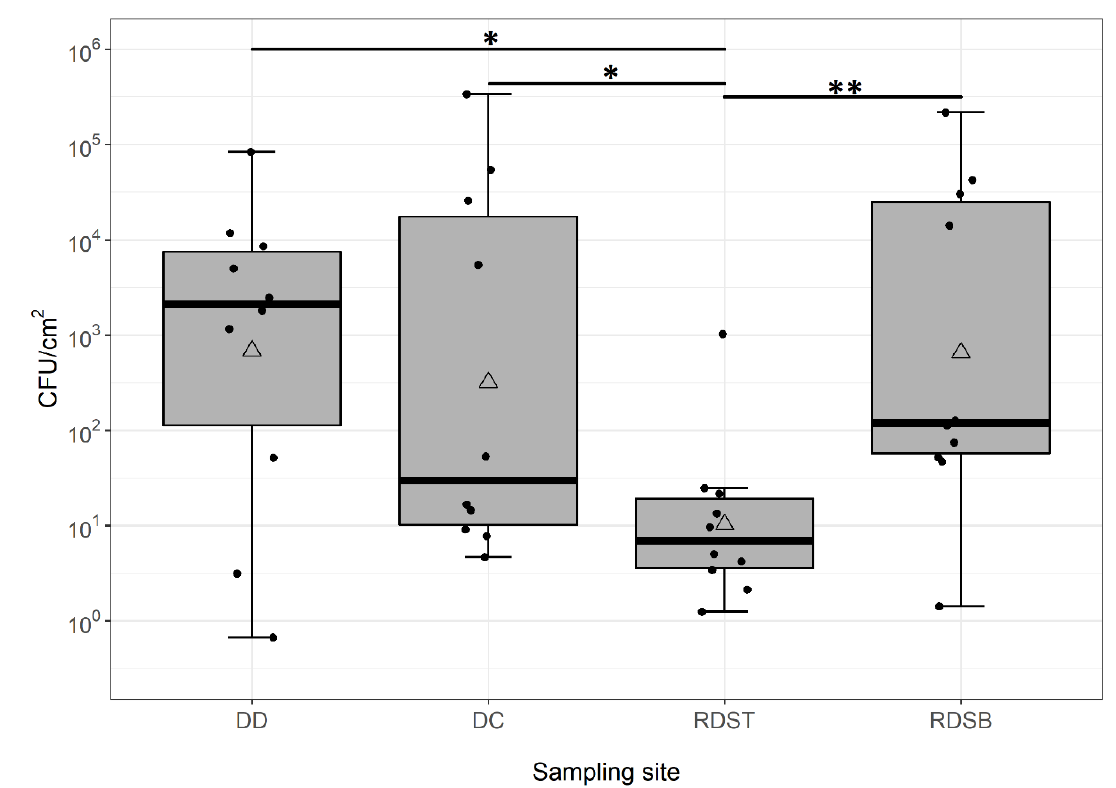
Figure 1. Box-whisker plots of aerobic colony counts per cm 2 from 4 sampling sites of 10 domestic washing machines. Each box represents the 25% and 75% percentiles. Bold horizontal lines represent medians. Mean values are displayed as triangles. Whiskers above and below the boxes indicate the lowest and highest microbial counts that were not classified as outliers. Black points represent single data points per site. The different sampling sites are detergent drawer (DD), detergent drawer chamber (DC), top part of rubber door seal (RDST), and bottom part of rubber door seal (RDSB) ( n = 10 for each sampling site). Results of Wilcoxon–Mann–Whitney post hoc tests are discussed in the text; significance levels are indicated by asterisks (* p < 0.05; ** p < 0.01).